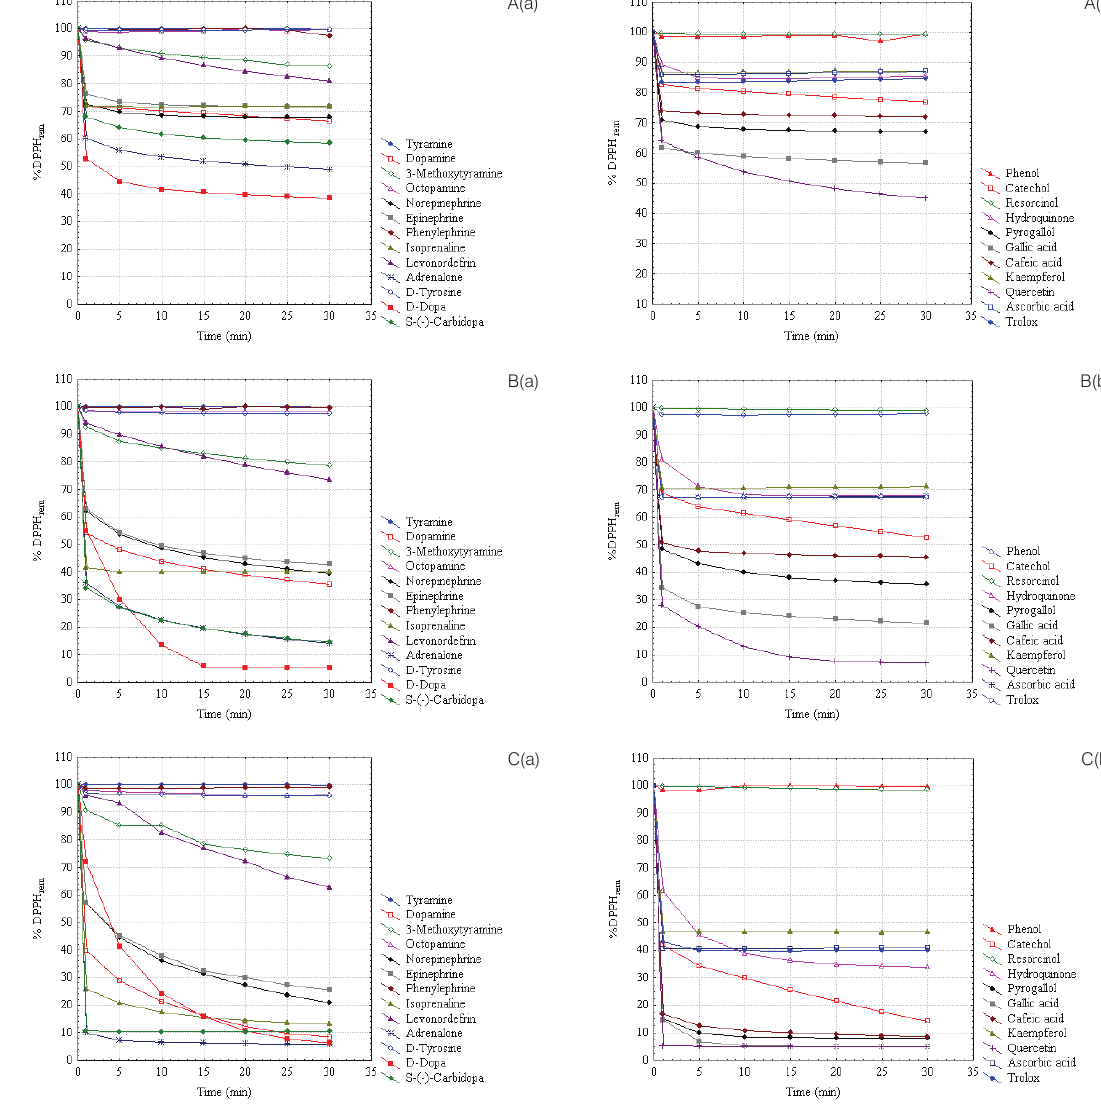
Figure 2. Effect of the investigated relative concentrations on the kinetic profiles of the investigated compounds: A) for [AH]/[DPPH • ] = 0.07 mol mol -1 ; B) for [AH]/[DPPH • ] = 0.13 mol mol -1 ; C) for [AH]/[DPPH • ] = 0.23 mol mol -1 were (a) and (b) refers to amines respectively reference antioxidants